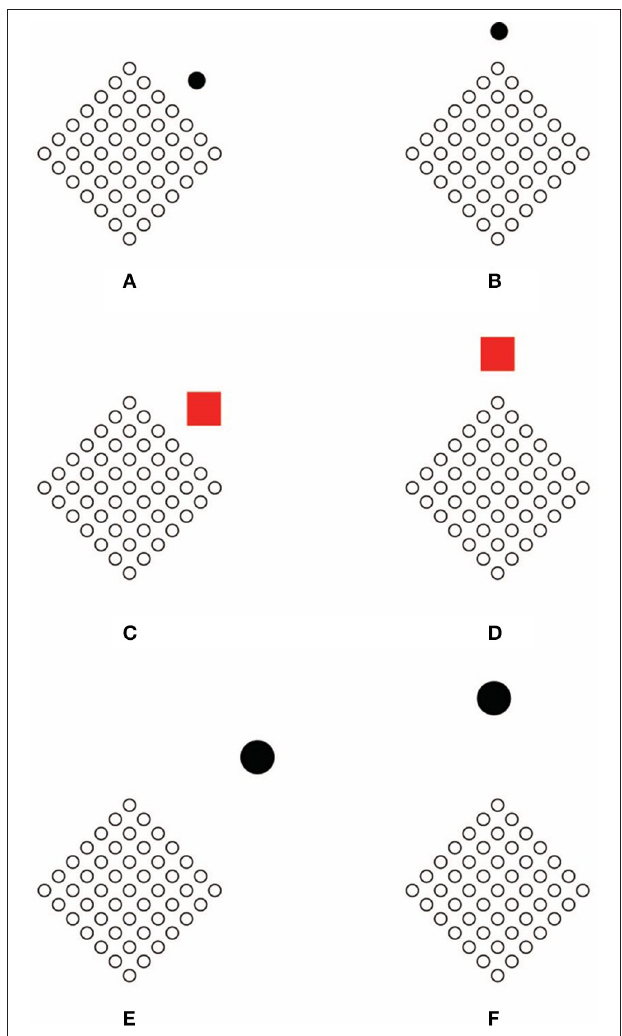
FIGURE 7 | The increasing of the distance between the two components of coupling does not weaken significantly the resulting effects: (cf. A,B with C,D with E,F) grouping and accentuation of the sidedness/rotated square (A,C,E) or pointedness/diamond (B,D,F).